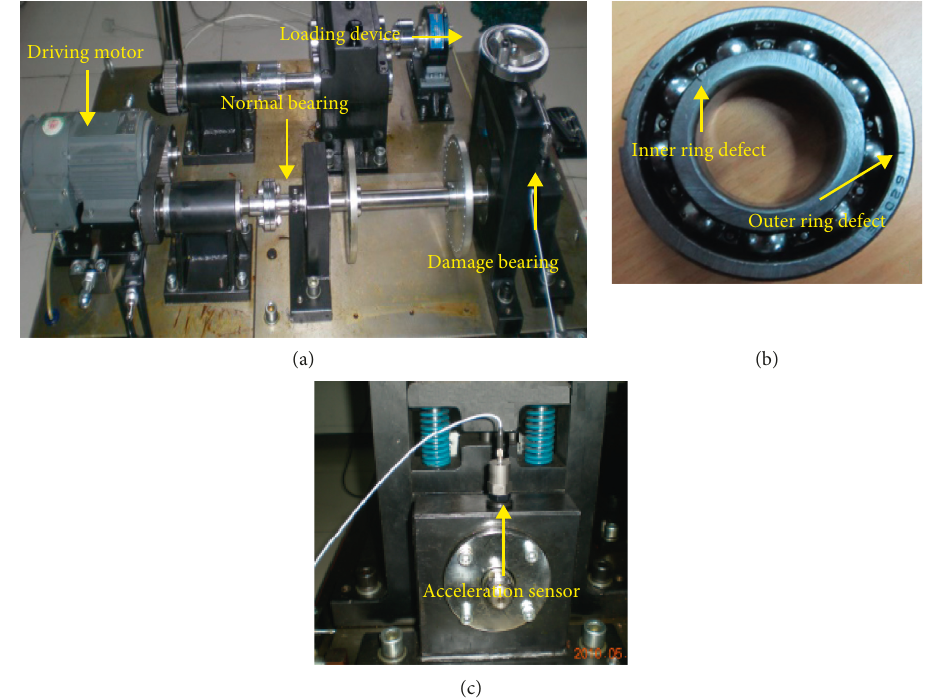
Figure 14: (a) QPZZ test platform; (b) bearing with inner and outer ring defects; (c) acceleration sensor